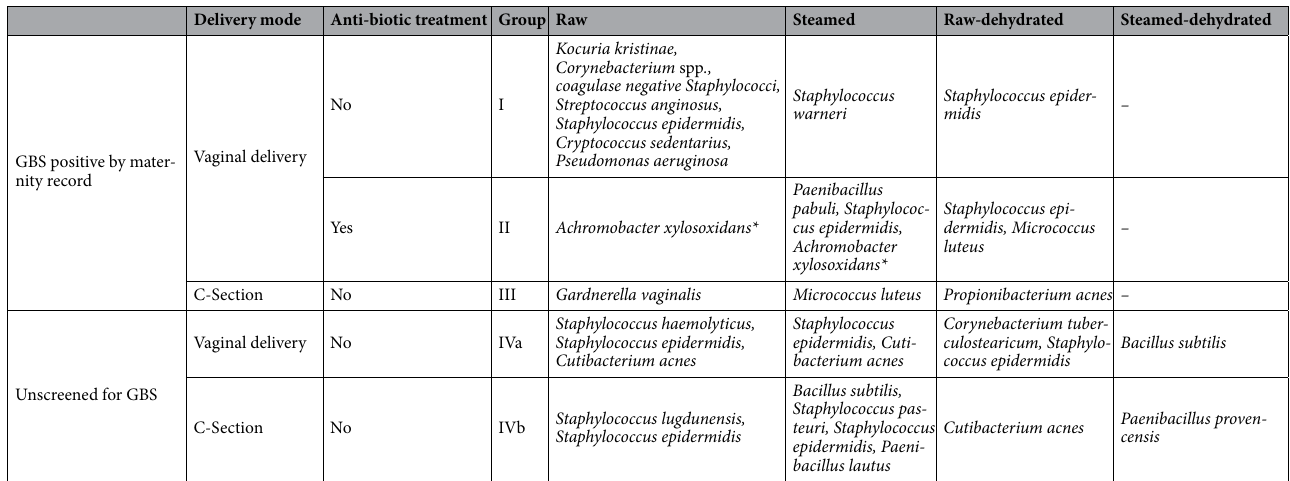
Table 3. Different species detected on raw, steamed, raw-dehydrated and steamed-dehydrated placenta preparations (n = 24). * Achromobacter xylosoxidans indicates contamination from tap water and growth was shown in surface